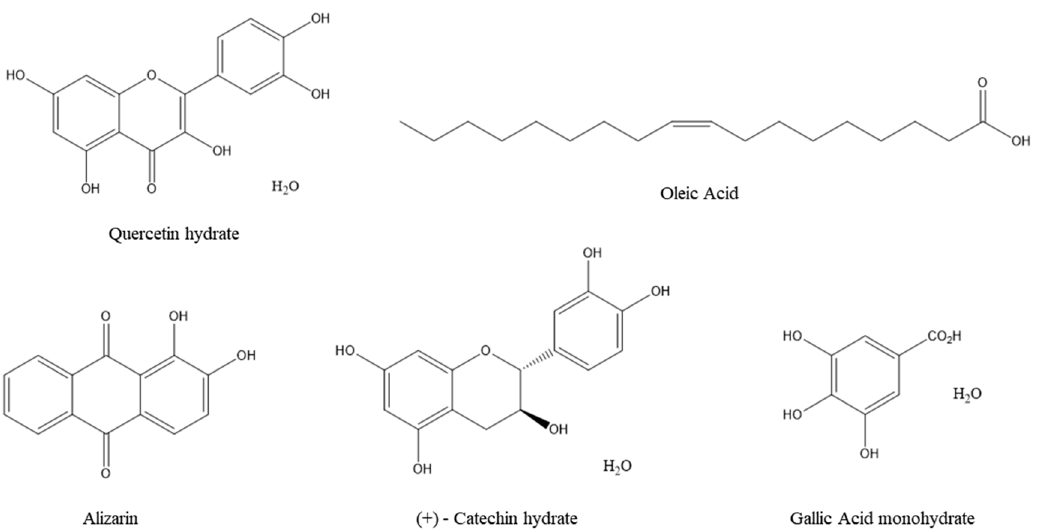
Figure 3. Structures of quercetin hydrate (QC), oleic acid (OA), alizarin (AZ), (+)-catechin hydrate (CH), and gallic acid monohydrate